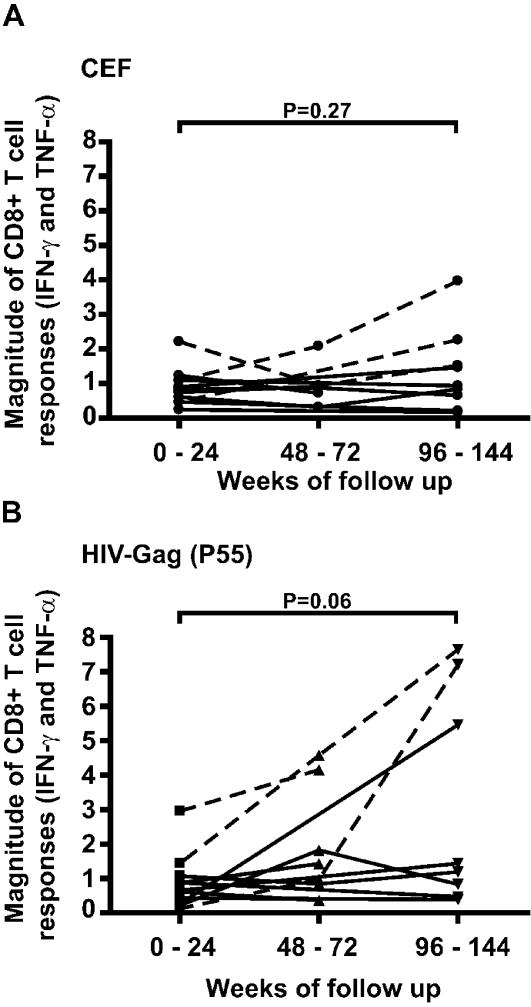
Increase of HIV-Gag responses over time.The cellular immune responses against the control peptide pools CEF (A) and HIV-Gag (B) were followed in longitudinally drawn PBMC samples. No statistically significant differences in CTL responses to non-HIV antigens included in the CEF peptide pool were seen over time (Paired T-test, p = 0.269). However, the increase in CTL response to the HIV-Gag (p55) peptide pool was borderline significant (Paired T-test, p = 0.064). The responses in subjects OP177, OP428 and OP599, who developed multiple HLA-A2-restricted CTL responses and showed evidence of viral escape within targeted epitopes, are indicated with dashed lines.